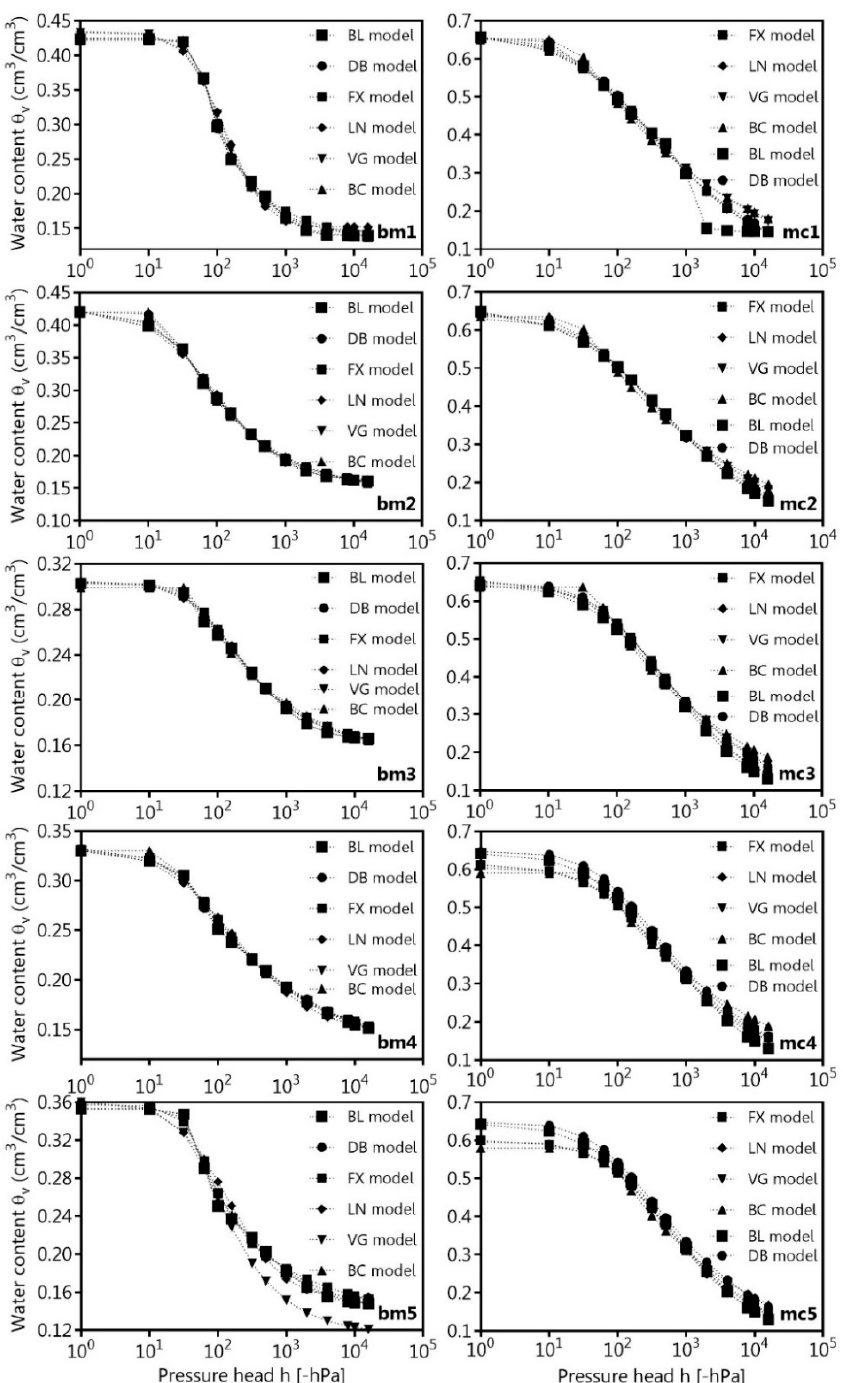
Figure 1. Bi- and unimodal soil water retention curves of the boulder marl (bm) and marsh clay (mc) for five different Proctor stages (bm1–bm5, mc1–mc5) of the following models: BC model [18], VG The goodness of fit for the SWRC parameters obtained with bimodal and unimodal models are listed in Table 6. The bimodal models showed minimally higher coefficients of determination (r 2 ≥ 0.98) than all unimodal SWRC. The DB model fit for the boulder marl and the BL model fit for the marsh clay were found to be best due to the more negative values of the AIC criterions as compared to all other models and for all degrees of Proctor density.